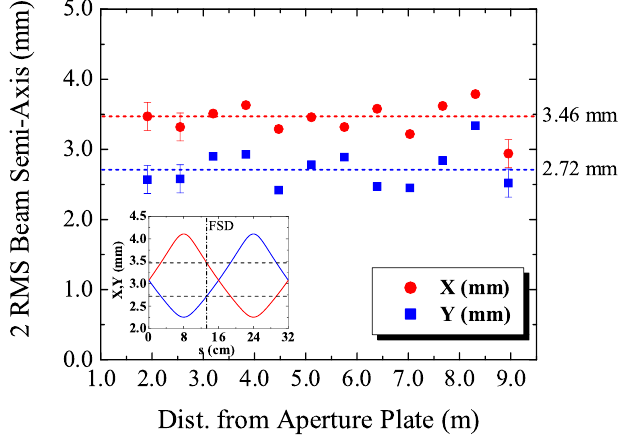
FIG. 12. (Color) Measured beam transverse dimensions (X: horizontal, Y: vertical) over 24 FODO periods in UMER for a 7.2 mA, 10 keV, electron beam. The horizontal dashed lines (cid:5) 72 : 92 (cid:12) at the represent calculated beam dimensions for (cid:5) 0 fluorescent screen diagnostics (FSD). FSD are available at every other FODO cell (ring chambers labeled ‘‘RC’’ in Fig. 1) at the plane indicated by the vertical dotted line in the inset. More details of similar experiments can be found in